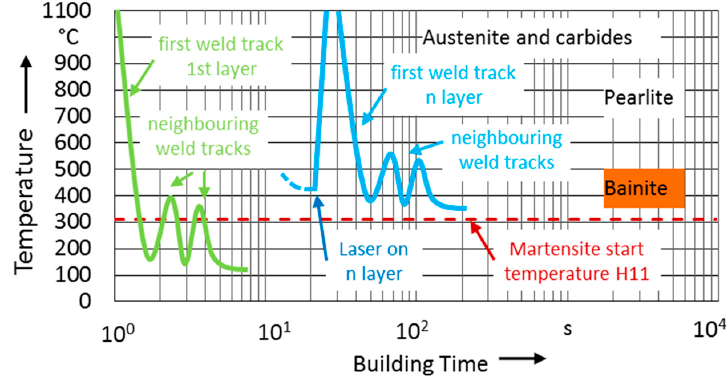
Figure A3. Schematic illustration of time-temperature-transformation curve for the first weld tracks at certain layers with microstructure-related aspects inspired by Reference [20].